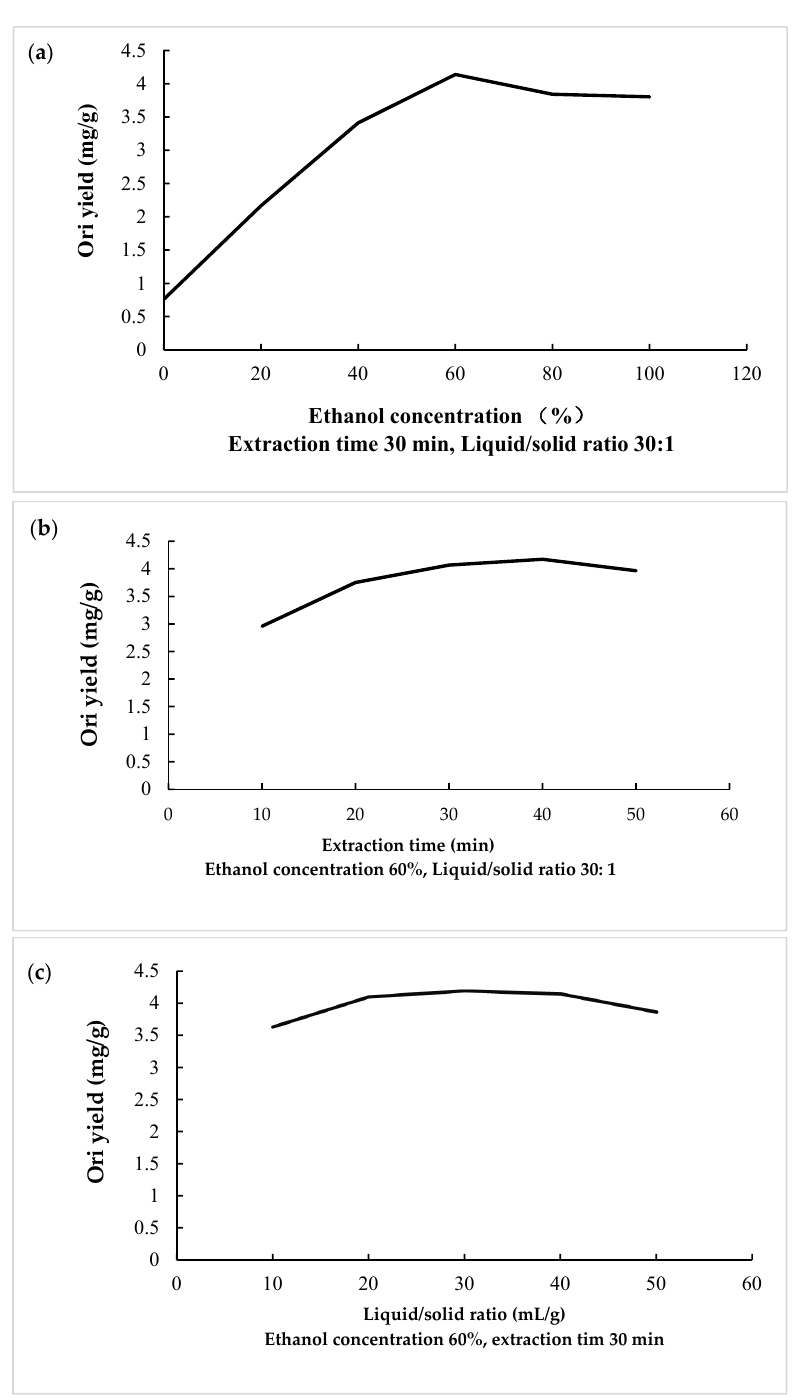
Figure 1. The influence of different factors on the extraction yield of Ori. ( a ) Effect of ethanol concentration on the yield of Ori, ( b ) Effect of extraction time on the yield of Ori, ( c ) Effect of liquid/solid ratio on the yield of Ori